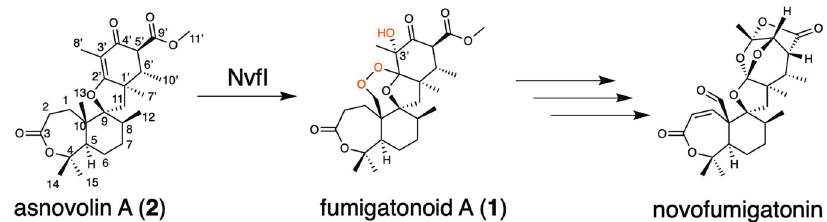
Fig. 1 The enzyme reaction of NvfI. NvfI catalyzes the production of fumigatonoid A ( 1 ) from asnovolin A ( 2 ). Subsequent modi fi cation reactions by other biosynthetic enzymes generate the fi nal product